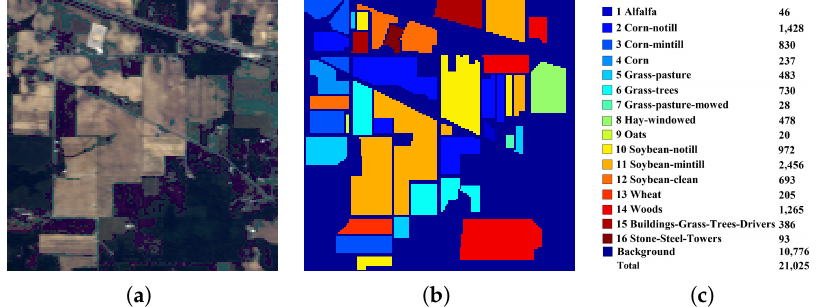
Figure 6. Indian Pines data with ( a ) color composite with RGB bands (29,19,9), ( b ) ground truth, and ( c ) category names with labeled samples.